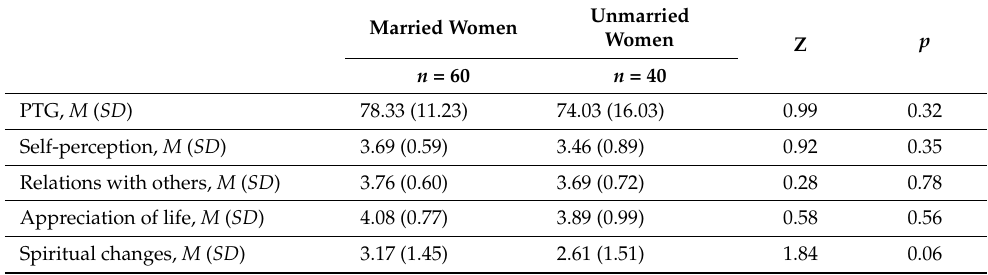
Table 6. Differences in post-traumatic growth and its components in married and unmarried women (Mann–Whitney U test).